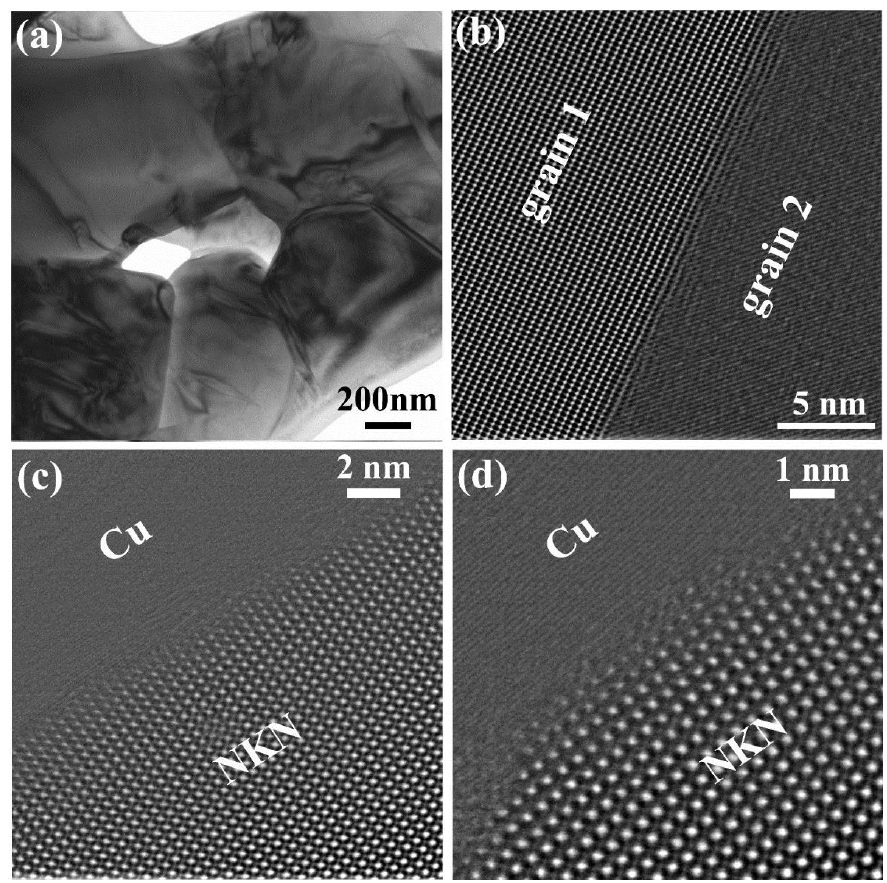
Figure 11. Cu-NKN MLCC (sintered at 1050 ° C). ( a ) The typical TEM micrograph of the grains; ( b , c , d ) Atomistic STEM images of the grain boundary and Cu/NKN interface, respectively.